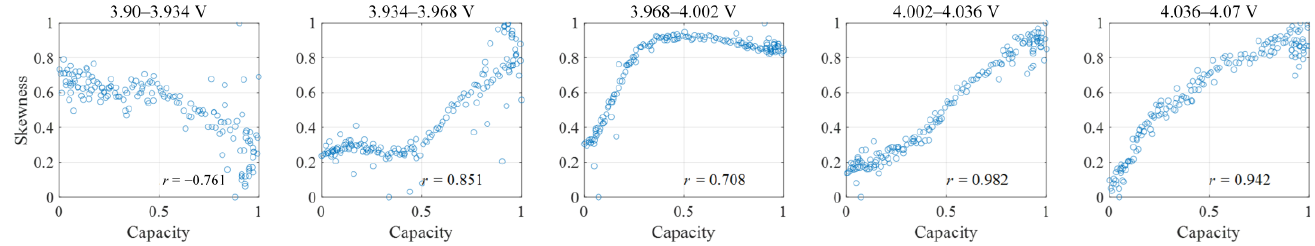
Figure 9. The correlation between capacity and skewness of NASA.